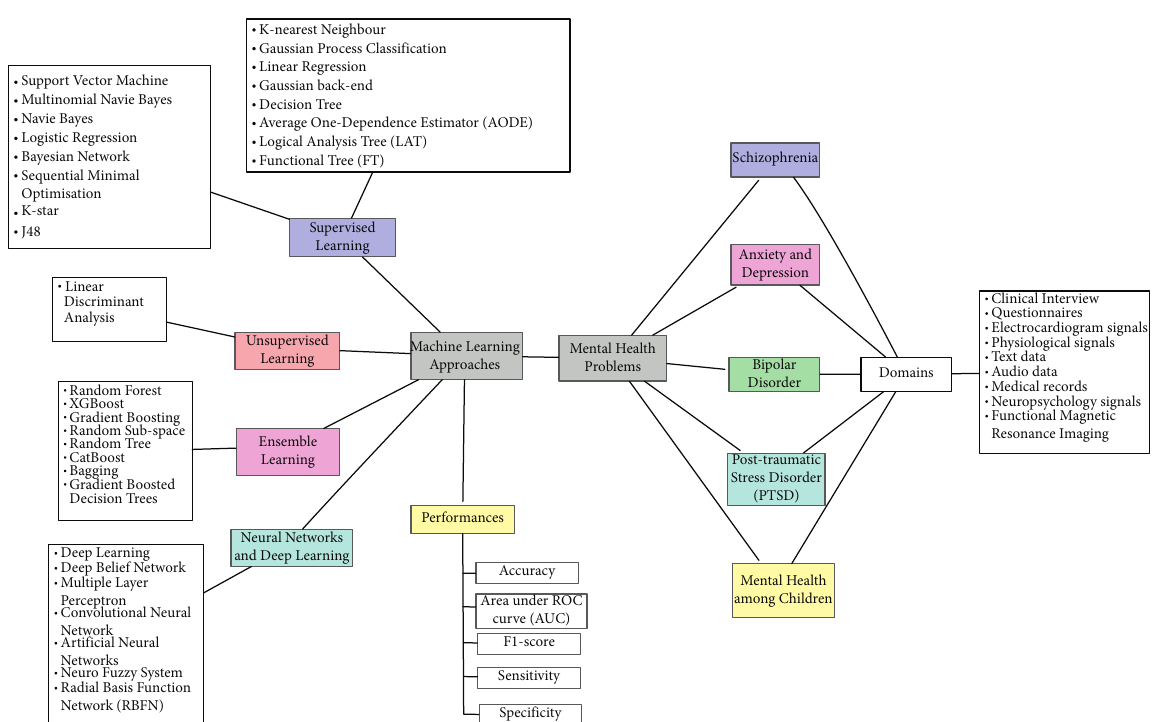
Figure 2: Taxonomy of the systematic literature review for this topic.